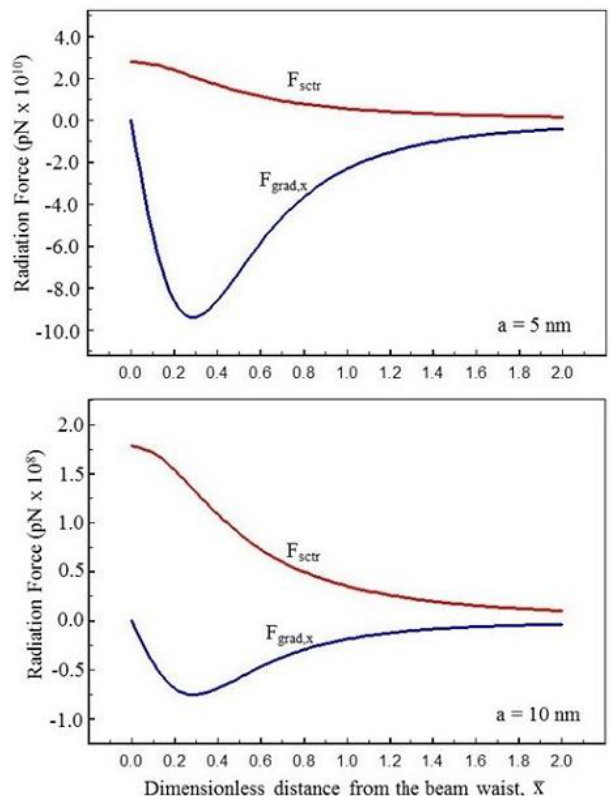
Figure 3. Scattering force, F sctr and the longitudinal component of the gradient force F grad,x as a function of the dimensionless x acting on a particle in water located on the beam center ( y = x = 0 ) , n p = 1.592, n f = 1.332, P o = 100 mW, lens focal length f = 75 mm, beam diameter D = 4 mm, wavelength λ = 532 nm